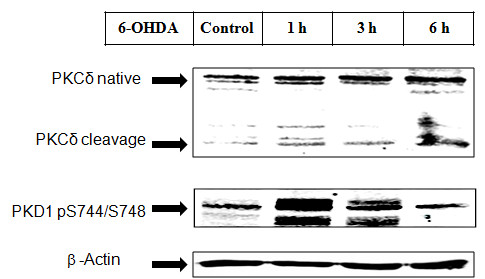
PKD1 is activated by 6-OHDA induced oxidative stress. N27 dopaminergic neuronal cells were treated with or without 6-OHDA (100 μM) for 1, 3, and 6 h and probed for PKD1 activation loop phosphorylation pS744/pS748 and PKCδ cleavage.